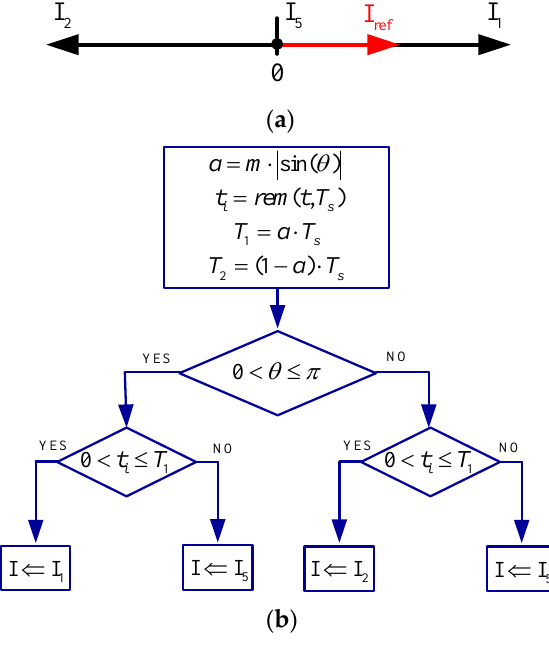
Figure 8. The schematic diagram. ( a ) The vector synthesis; ( b ) The vector allocation.